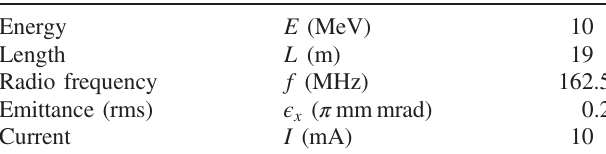
TABLE I. The main parameters of injector scheme II.